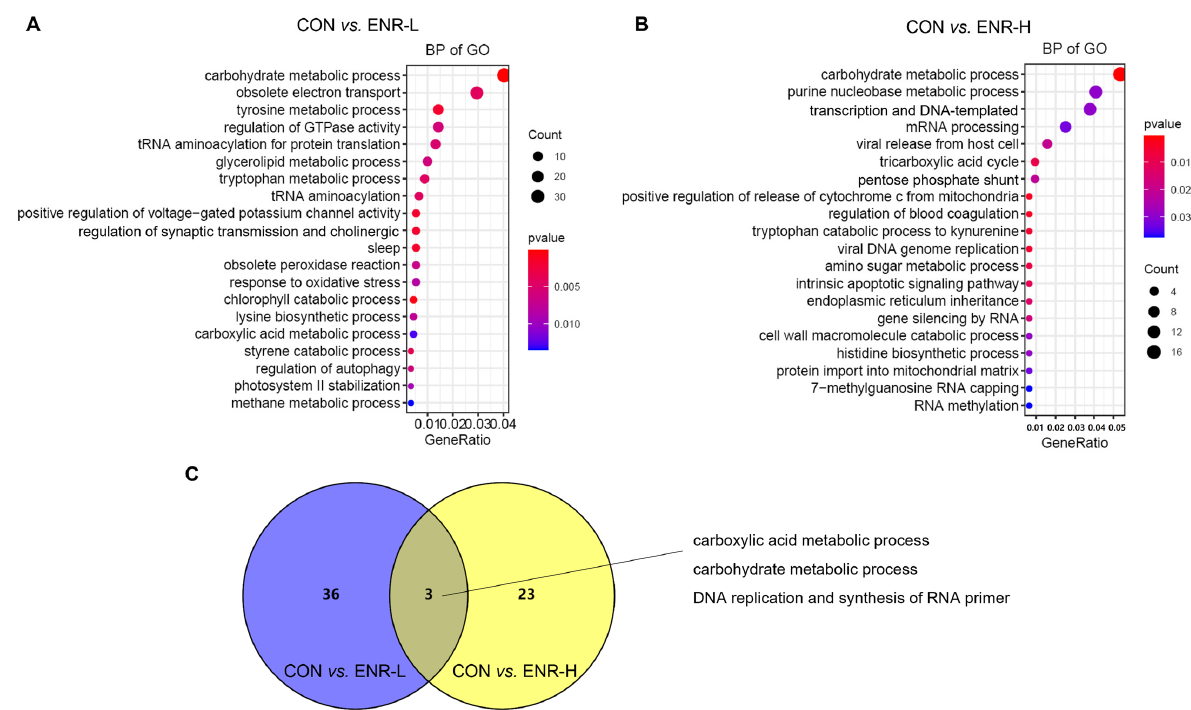
Figure 3. Gene ontology (GO) analysis of the differentially expressed genes (DEGs) in the E. sinensis hepatopancreases following different exposure doses of enrofloxacin. Colors represent p -values. The x-axis represents the gene ratio. The y-axis represents GO terms involved in biological processes. Venn diagrams showing number of biological processes in E. sinensis hepatopancreas samples following ( A ) low and ( B ) high enrofloxacin exposure doses. ( C ) Enrichment of DEGs of the three common biological processes affected by both low (blue) and high (yellow) enrofloxacin exposure doses.